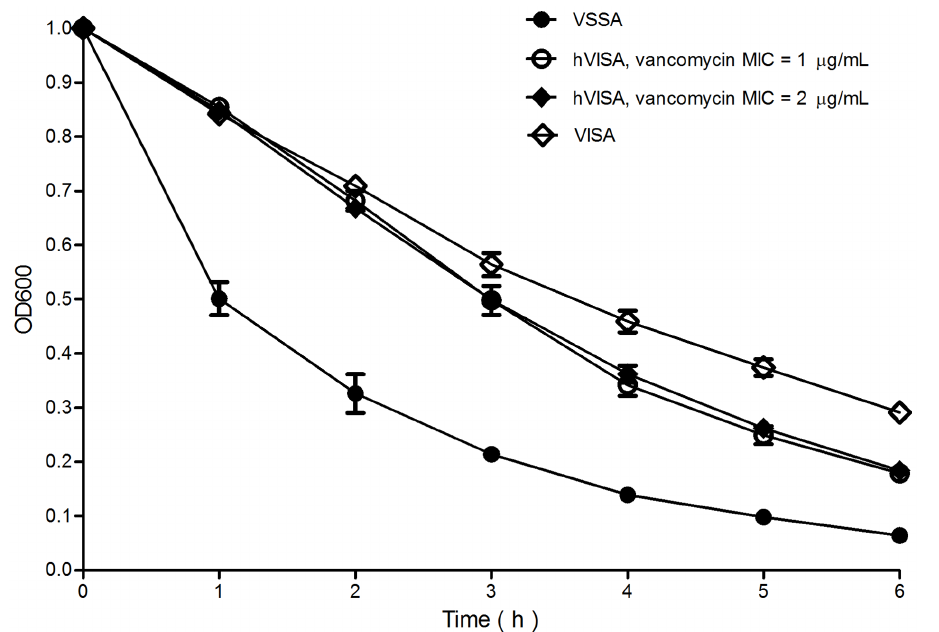
Figure 2. Autolysis assay results for 129 VSSA, 76 hVISA, and 4 VISA isolates. The results are expressed as the mean OD values of five independent experiments. Black circles indicate the mean OD values of 129 VSSA by hour; white circles and black rhombuses indicate the mean OD values of 21 hVISA with a vancomycin MIC of 1 m g/mL and the mean OD values of 55 hVISA with a vancomycin MIC of 2 m g/mL by hour, respectively; white rhombuses indicate the mean OD values of 4 VISA by hour.